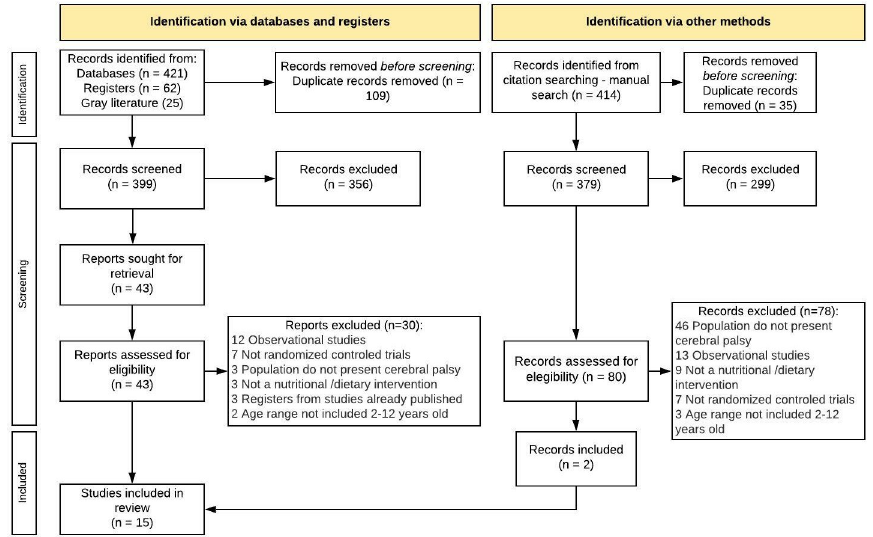
Fig 1. Flow-chart illustrating the search and selection